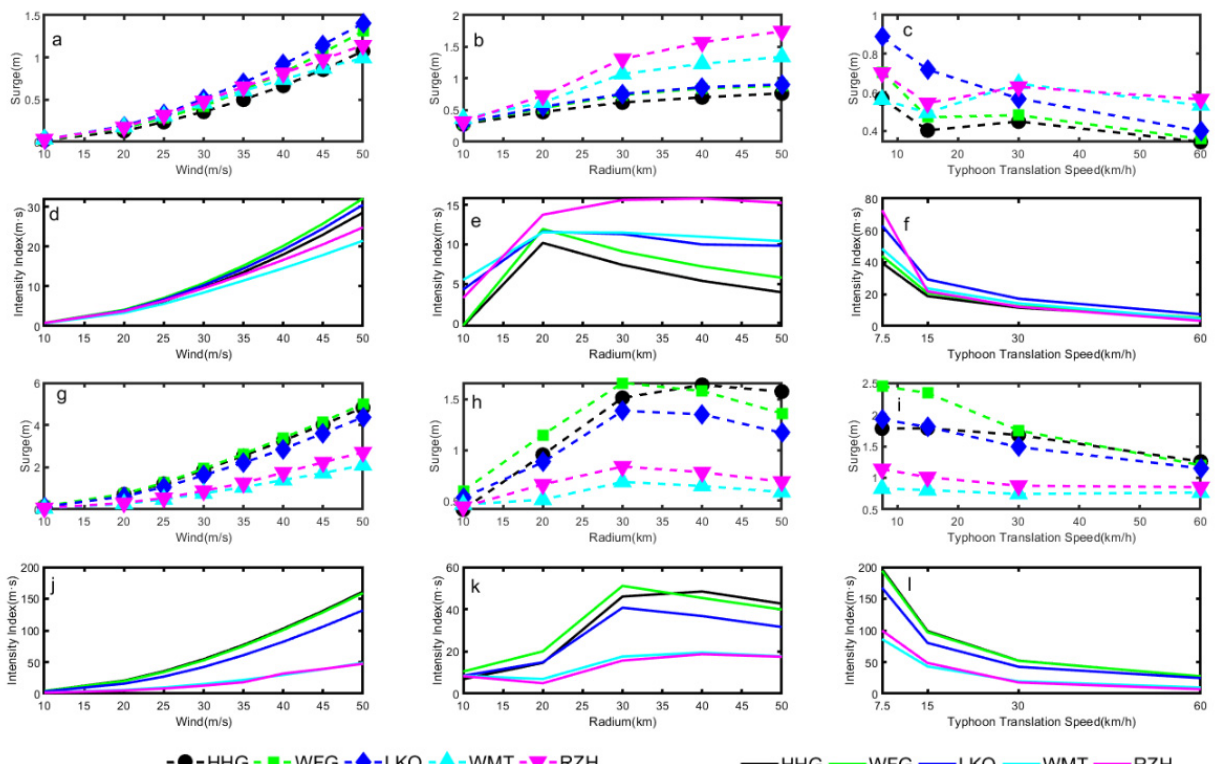
Figure 20. Variation in the maximum value of the storm surge (Intensity Index) with the ( a – d ) max- imum wind speed, ( b – e ) typhoon radius, and ( c – f ) typhoon translation speed for Typhoon Muifa. Variation in the maximum value of the storm surge (Intensity Index) with the ( g – i ) maximum wind speed, ( h – k ) typhoon radius, and ( i – l ) typhoon translation speed for Typhoon Lekima.